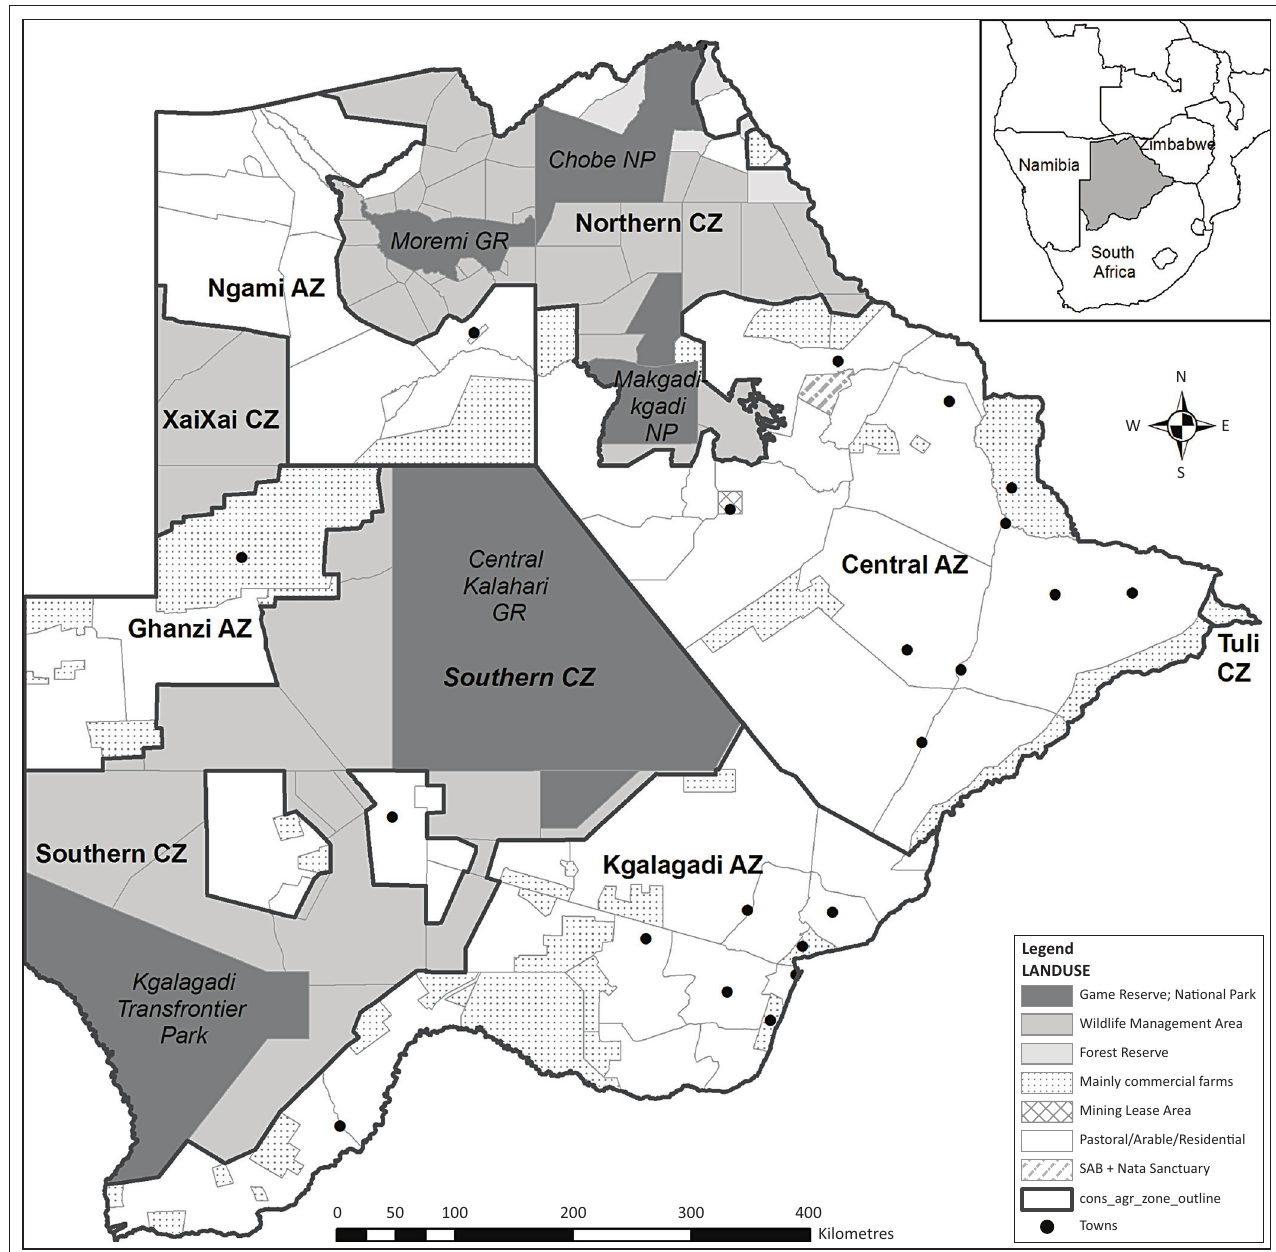
FIGURE 1: Primary land use in Botswana, including the conservation zones (national parks, game reserves and Wildlife Management Areas) and agricultural zones (commercial farms and communal land with cattle posts). Insert shows Botswana in relation to southern